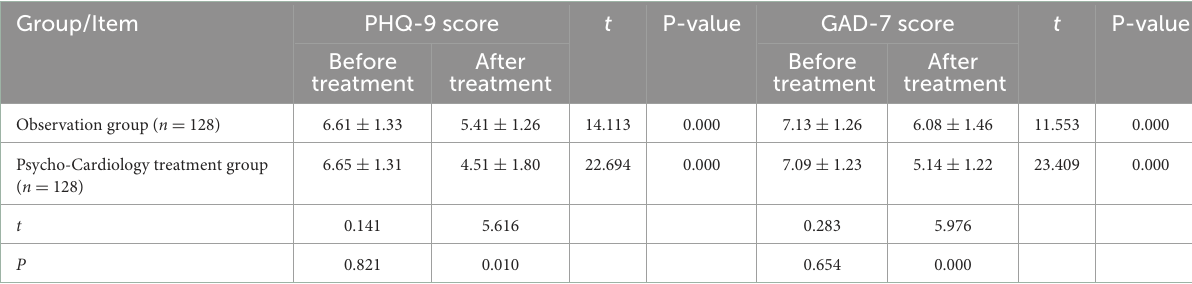
TABLE 2 Inter-group comparison of PHQ-9 and GAD-7 scores before and after treatment [ n ( x ± s )].